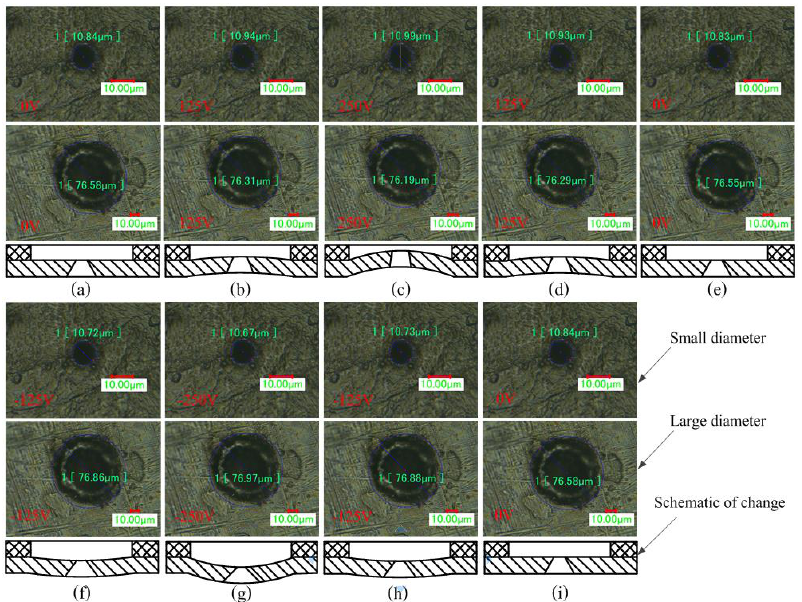
Figure 7. Measurement results of the aperture parameters and corresponding schematics. ( a ) First measurement, applied DC voltage of 0 V; ( b ) second measurement, applied DC voltage of 125 V; ( c ) third measurement, applied DC voltage of 250 V; ( d ) fourth measurement, applied DC voltage of 125 V; ( e ) fifth measurement, applied DC voltage of 0 V; ( f ) sixth measurement, applied DC voltage of −125 V; ( g ) seventh measurement, applied DC voltage of −250 V; ( h ) eighth measurement, applied DC voltage of −125 V; ( i ) ninth measurement, applied DC voltage of 0 V.